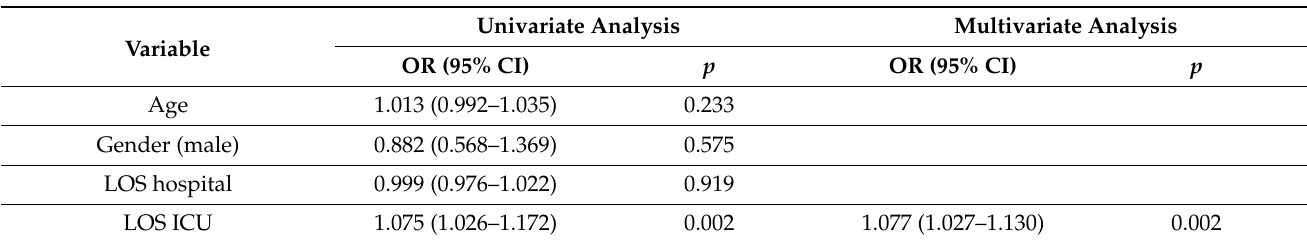
Table 3. Binomial logistic regression analysis of BUN for in-hospital mortality among critically ill patients with AECOPD (after